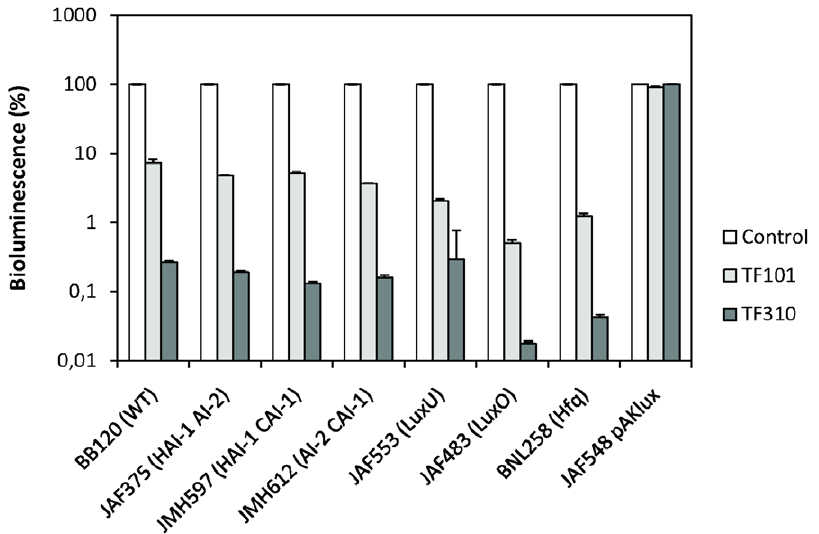
Figure 2. Bioluminescence of the V.harveyi wild type (BB120), the double mutants JAF375 (sensor HAI-1 2 , sensor AI-2 2 , sensor CAI- 1 + ), JMH597 (sensor HAI-1 2 , sensor AI-2 + , sensor CAI-1 2 ) and JMH612 (sensor HAI-1 + , sensor AI-2 2 , sensor CAI-1 2 ), the constitutively luminescent quorum sensing signal transduction cascade mutants JAF553 (LuxU), JAF483 (LuxO) and BNL258 (Hfq), and strain JAF548 pAKlux1 (in which bioluminescence is independent of the quorum sensing system), with and without the thiophenones (2.5 m M). Luminescence measurements were performed 0.5 h after the addition of the thiophenones. For each strain, the bioluminescence without the addition of thiophenone was set at 100% and the other samples were normalised accordingly. The error bars represent